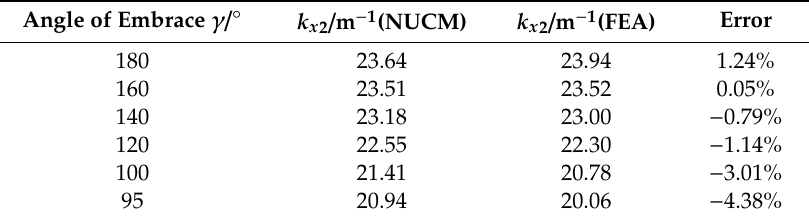
Figure 7. Variation of the principal curvature with respect to the angle of embrace γ . Table 4. Principal curvature of anti-symmetric cylindrical shells with different angle of embrace from analytical model and simulation.